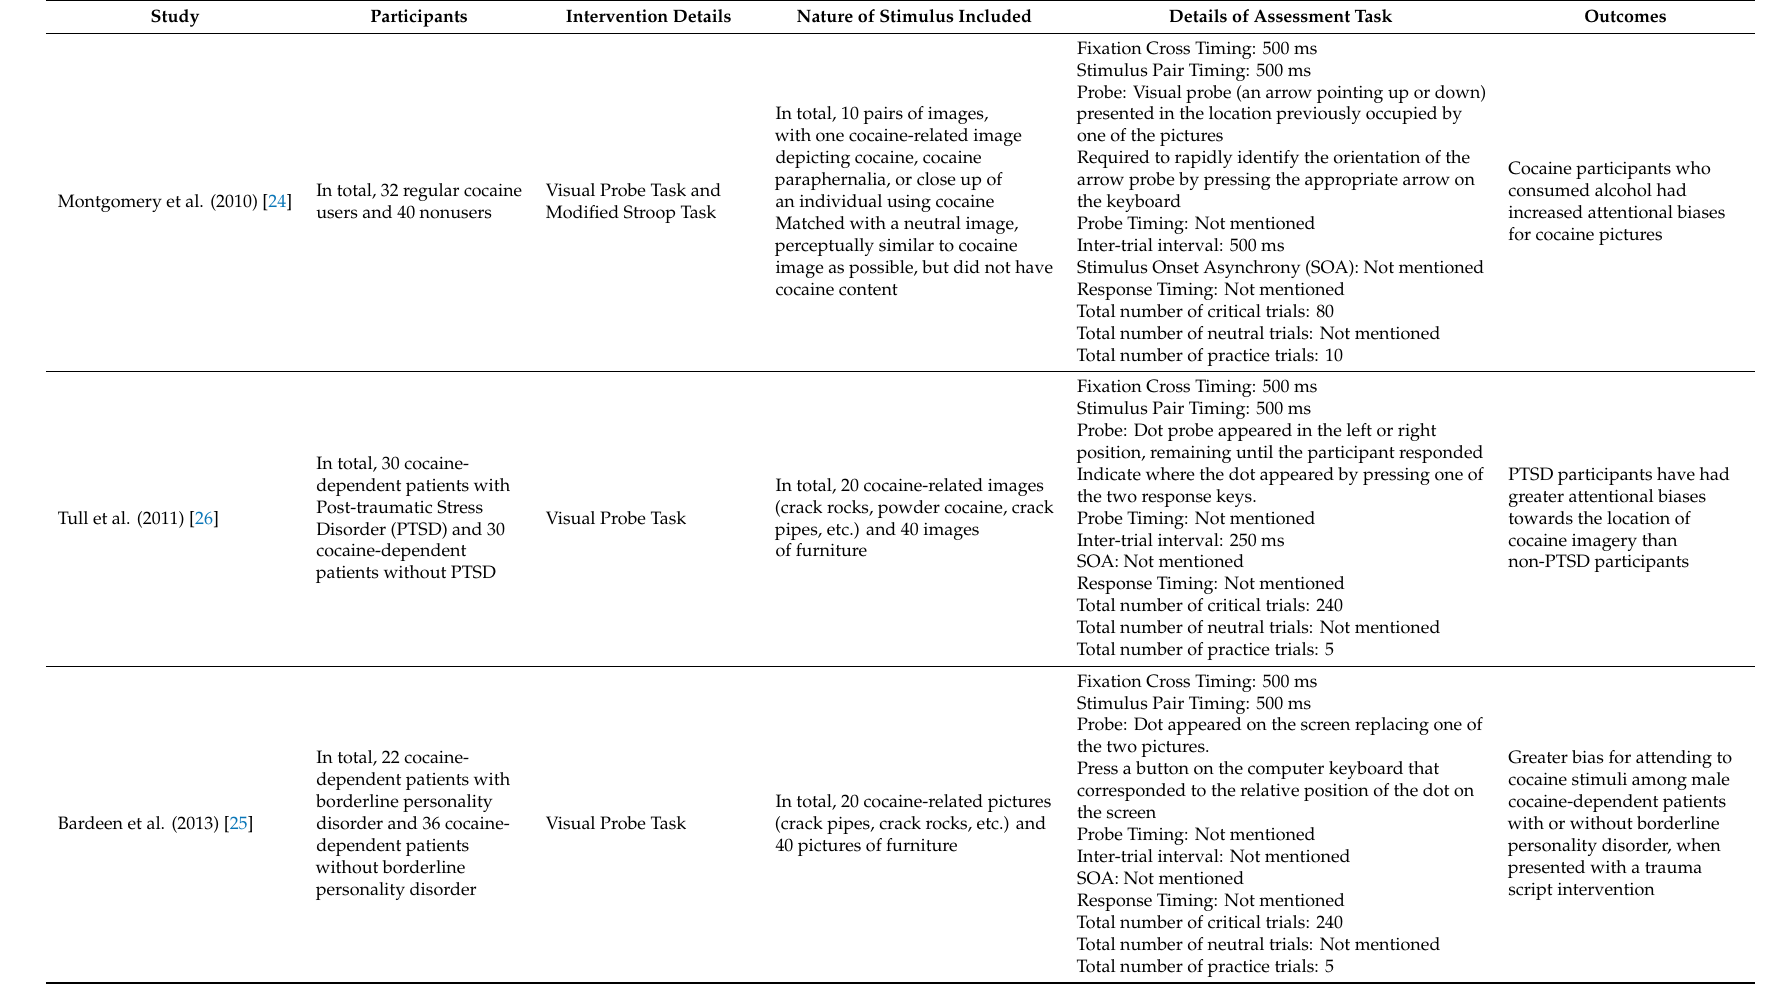
Table 3. Characteristics of the Visual Probe Task used in previous studies involving individuals with stimulant